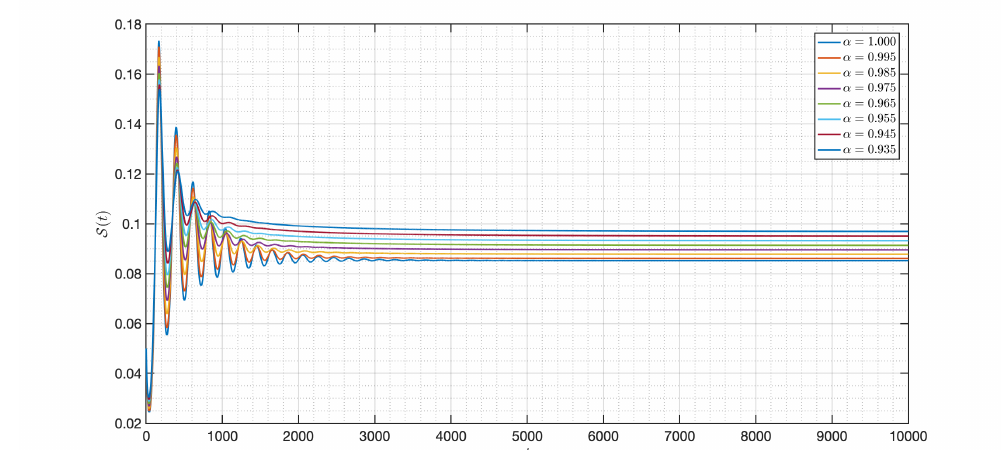
Figure 35. Dynamic of N ( t ) of the model (3) for different parameters in Case IV .